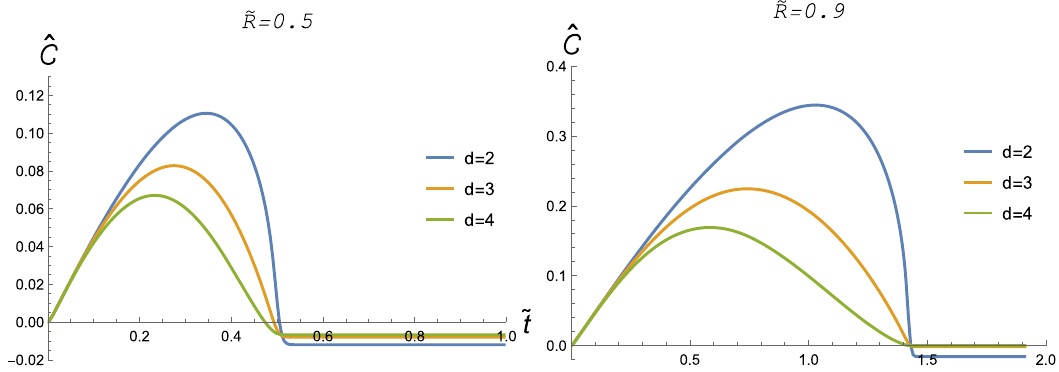
Fig. 3 Time evolution of normalised HSCV density ˆ C for various d with fixed ˜ R . The mass is fixed as M = 1